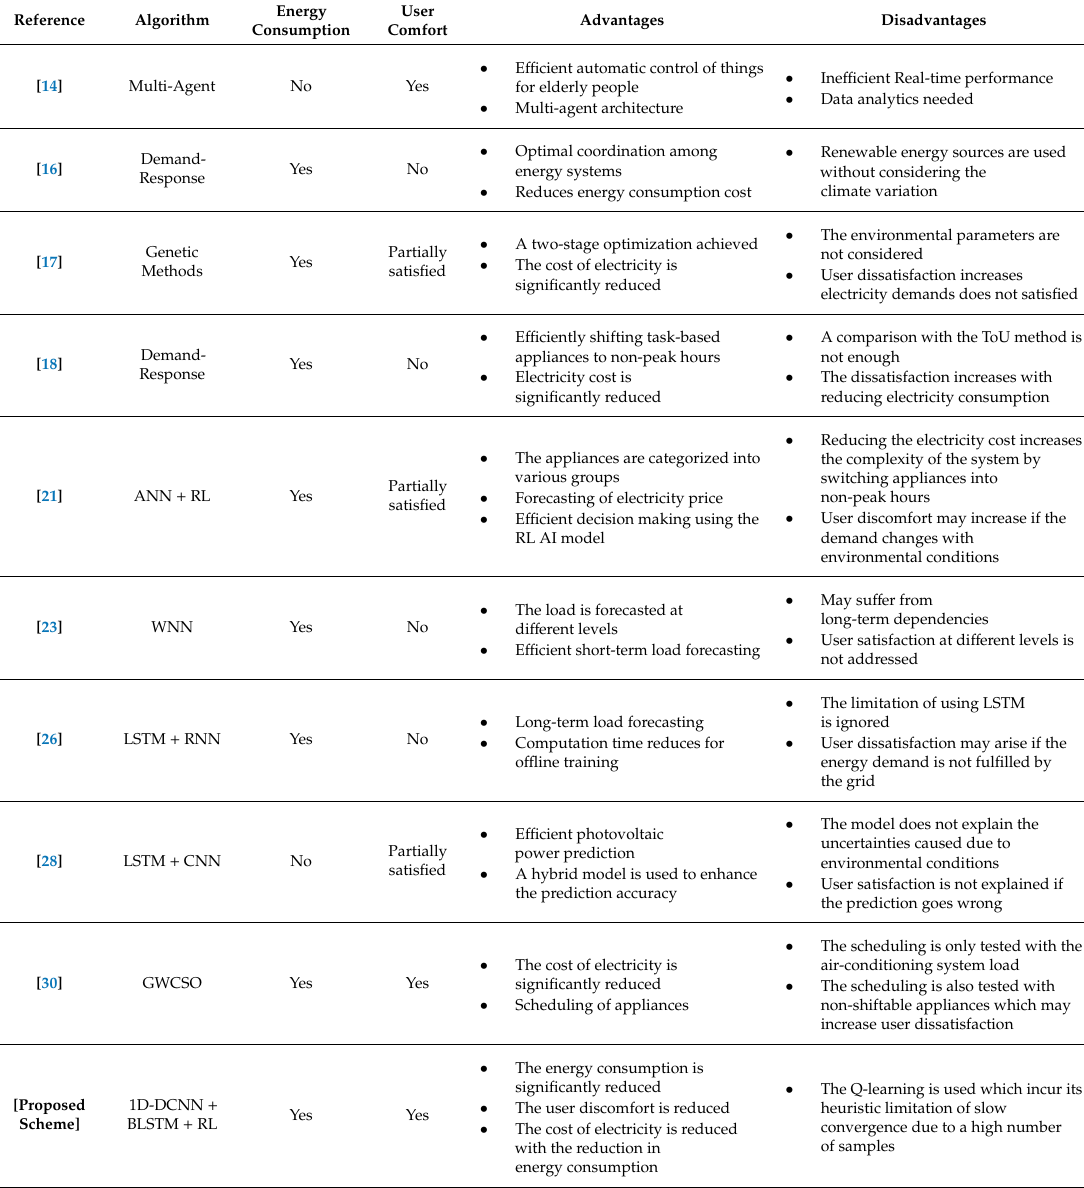
Table 1. Summary of the main schemes discussed in the